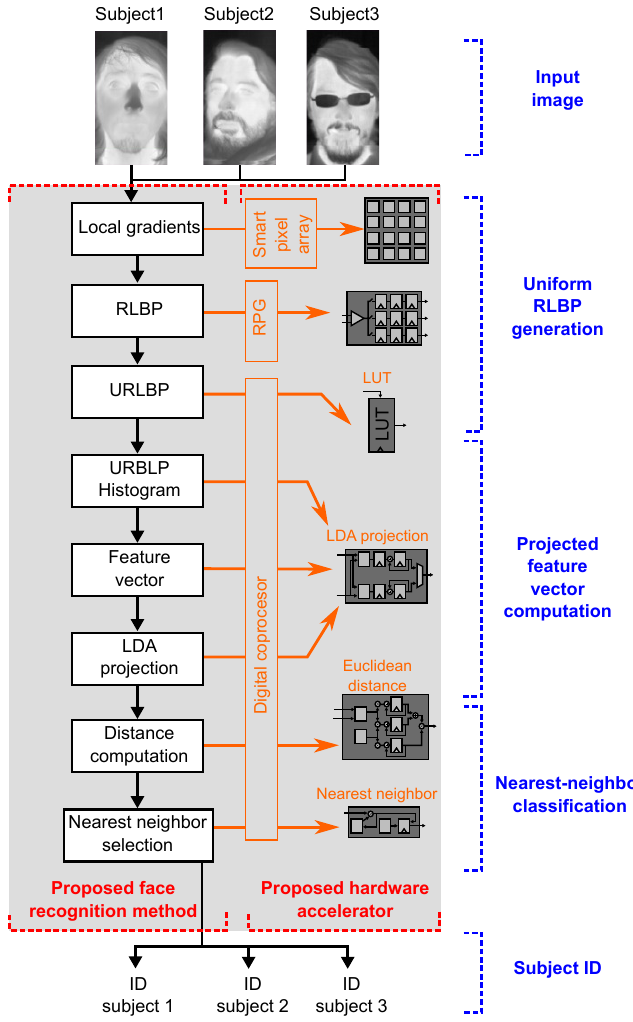
Figure 1. Proposed method and hardware accelerator. The left hand side illustrates the steps of our face recognition algorithm. The right hand side shows the elements of our SIS, namely smart-pixel array, pattern generator, and digital coprocessor, which execute the stages of the